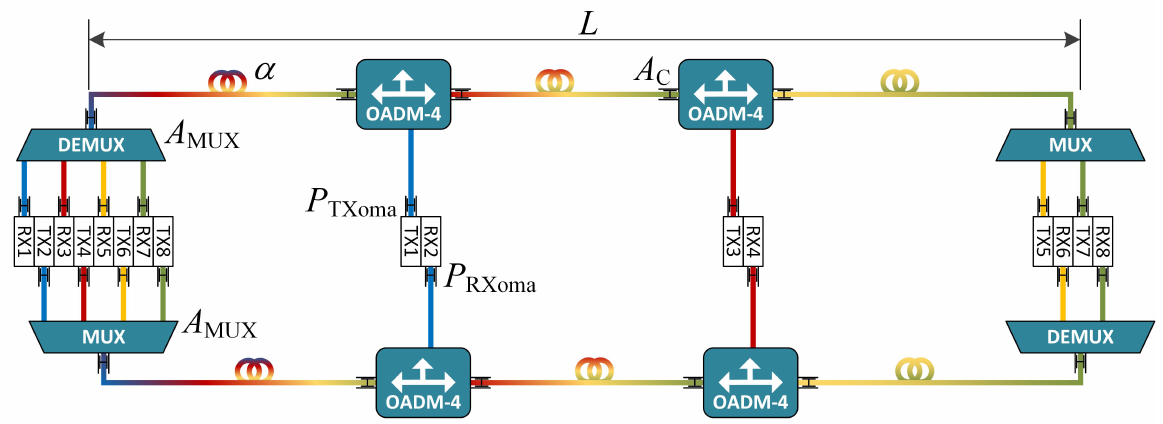
Figure 2. System configuration with denoted parameters necessary to estimate the transmission distance L .